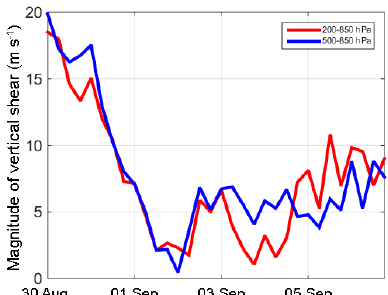
Figure 2. Magnitude of vertical wind shear. Shear is shown for the 200–850hPa (red line) and the 500–850hPa (blue line) levels. Shear decreased from ∼ 20ms − 1 on 30 August 2010 to ∼ 2ms − 1 on 2 September 2010. Although the shear is below the nominal value of 12ms − 1 , there is still persistent shear on the pouch. These re- sults are consistent with previous studies by Davis and Ahijevych (2012).